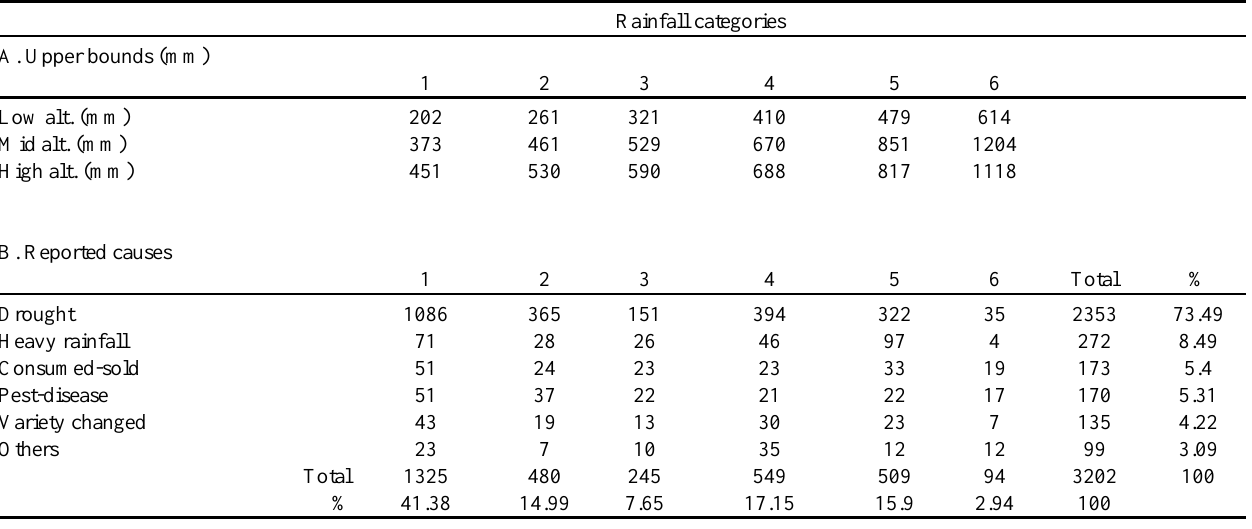
Table 1 . Variety losses and causes reported by farmers, for the 1961-2006 period, and their distribution among six categories of increasing seasonal rainfall. A. Upper bounds of rainfall categories (mm). B. Causes reported by farmers to explain variety losses.